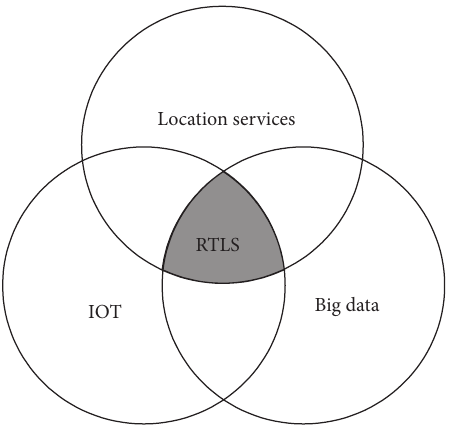
Figure 1: RFID-based real-time location